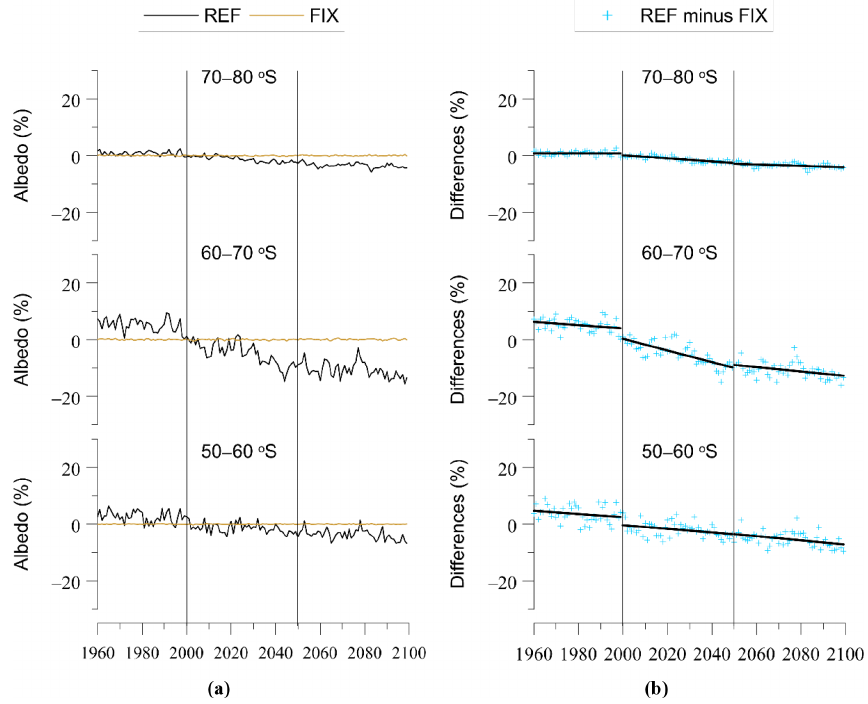
Figure C2. Same as Fig. C1 but for 50–60, 60–70, and 70–80 ◦ S. The y axis in (a) shows yearly averaged surface albedo data (in %) calculated from de-seasonalized monthly data. The monthly data were de-seasonalized relative to the long-term monthly mean (1990–2019) and were expressed in percent. For the southern high latitudes, the annual average refers to the average of monthly anomalies from September to March.